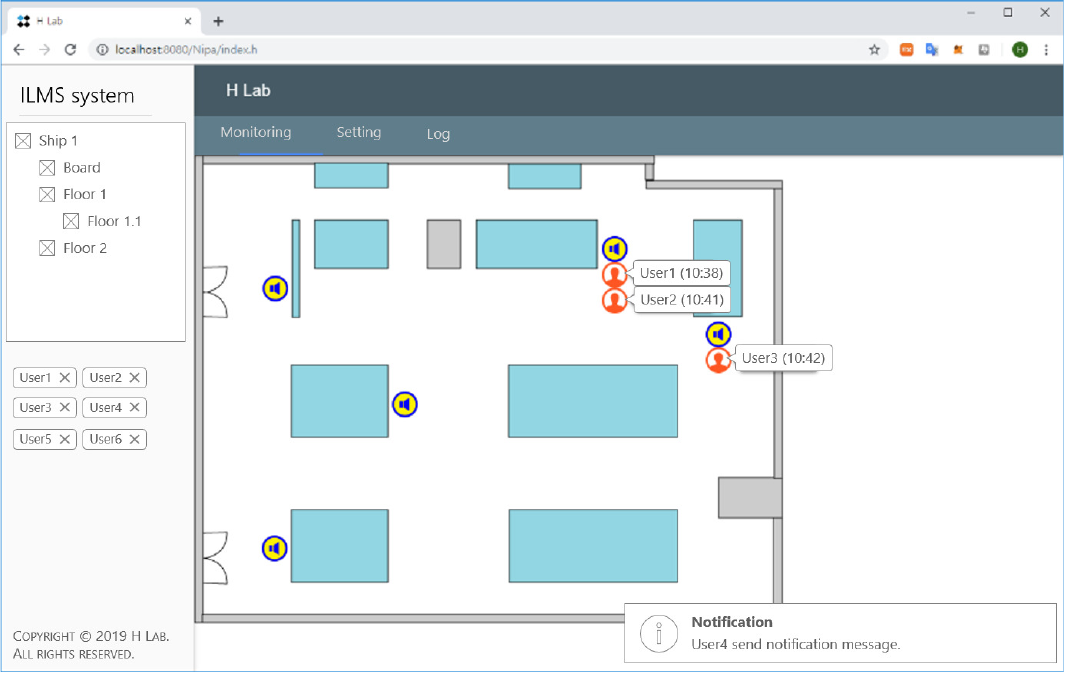
Figure 7. Worker location monitoring service screen of the ILMS